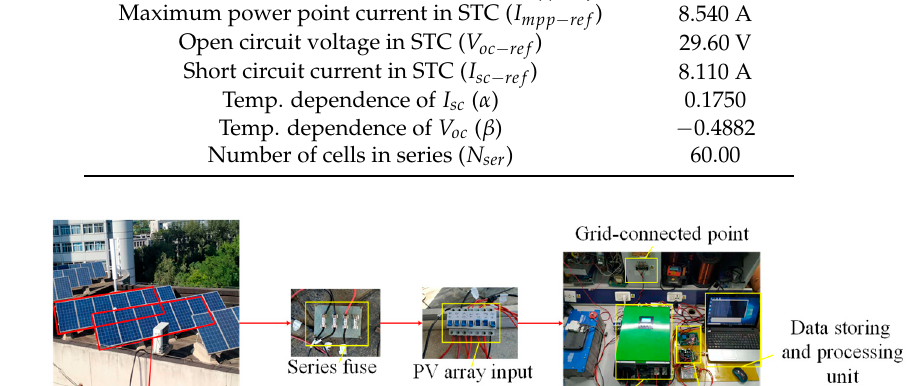
Table 6. Key specifications of GSP-240 PV Module.